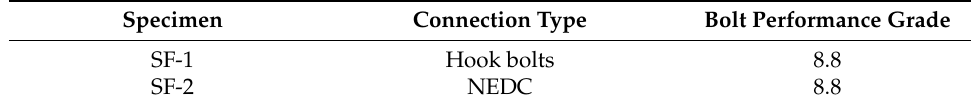
Table 1. Specimens used for the test and their characteristics.